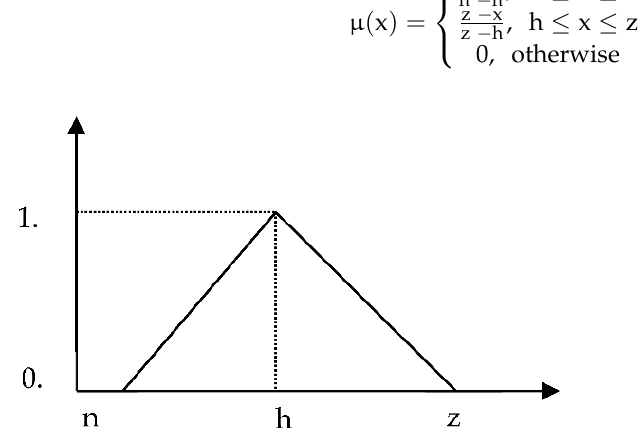
Figure 4. Fuzzy triangular number.